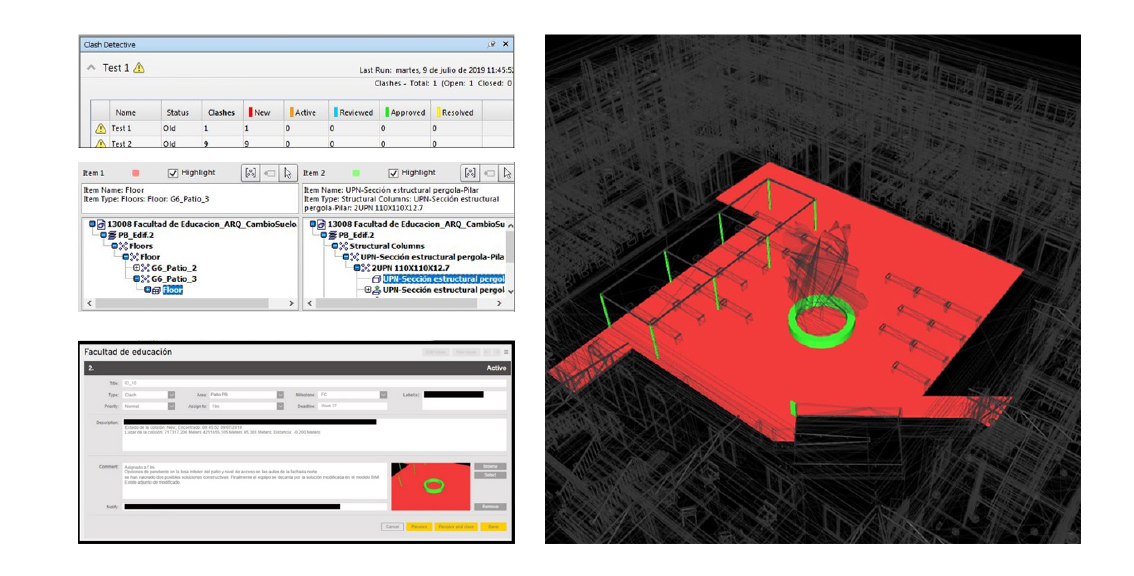
Figure 8. Management of conflict in work detected in Look Ahead Meeting (LAM) 31 through navisworks and registration of the conflict through